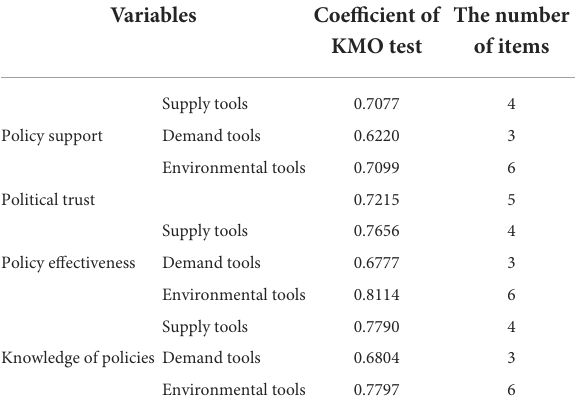
TABLE 6 Kaiser-Meyer-Olkin test of key